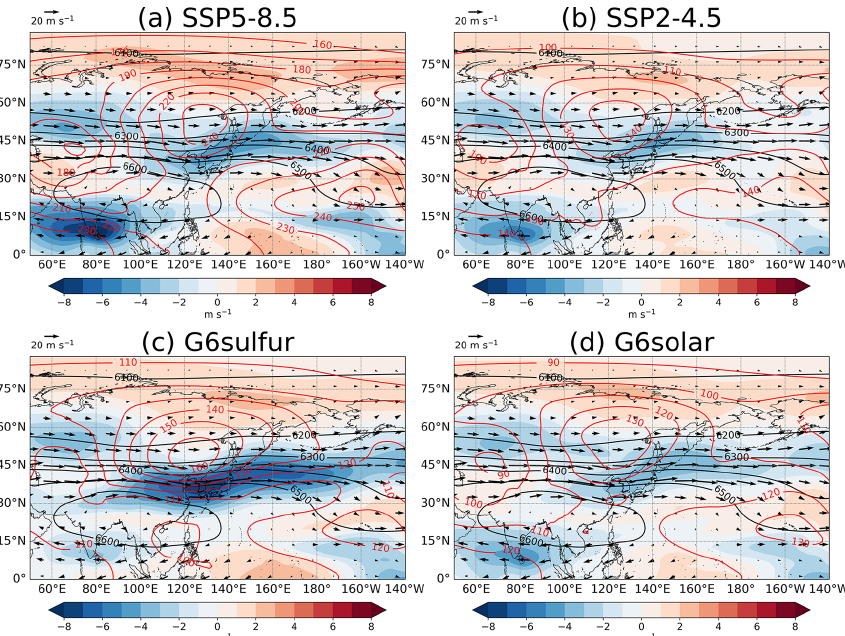
Figure 4. Absolute changes in MJJAS mean geopotential thickness between 200 and 500hPa (red contours; unit is gpm) and 200hPa wind speeds (shaded) for the future period of 2071–2100 relative to the historical baseline during 1981–2010. Black contours (unit in gpm) show the MJJAS mean 200–500hPa geopotential thickness, and vectors show the MJJAS mean 200hPa wind fields during the historical baseline period.